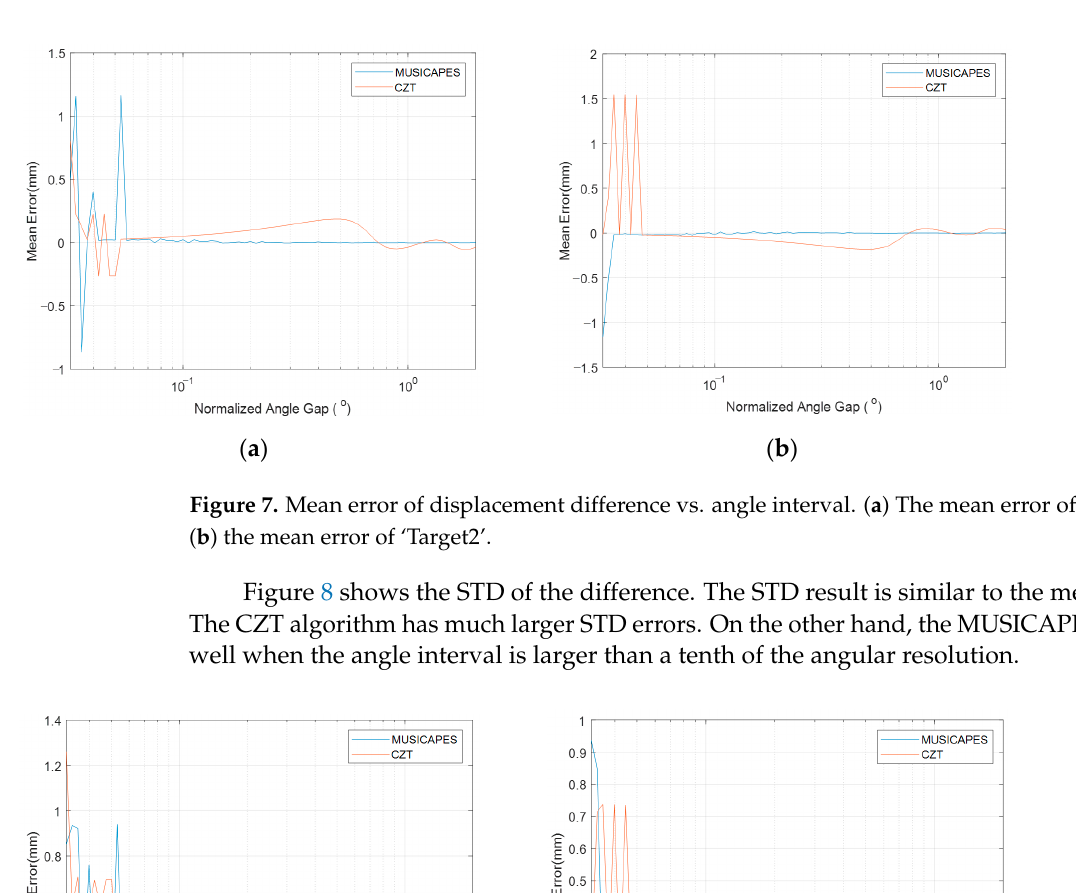
( b ) Figure 6. Displacement curves of the real value and the estimated ones. ( a ) The real value of dis- placement; ( b ) the displacement curves estimated by MUSICAPES and CZT. The performances are further analyzed at different angle intervals between the two targets. ‘Target1’ is fixed at (20 m, 0°) and the azimuth angle of ‘Target2’ is variable. The angle interval between them varies exponentially from 10 − 1.5 θ ρ to 10 0.5 θ ρ . The angular resolution